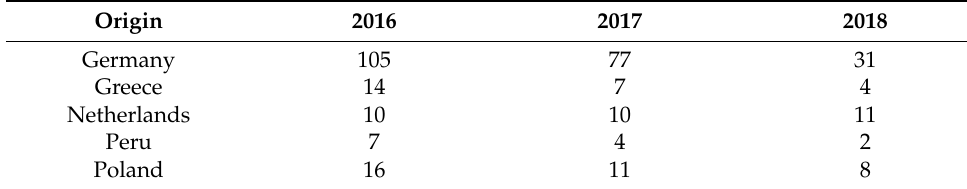
Table 3. Overview of the analyzed samples regarding geographical origin.